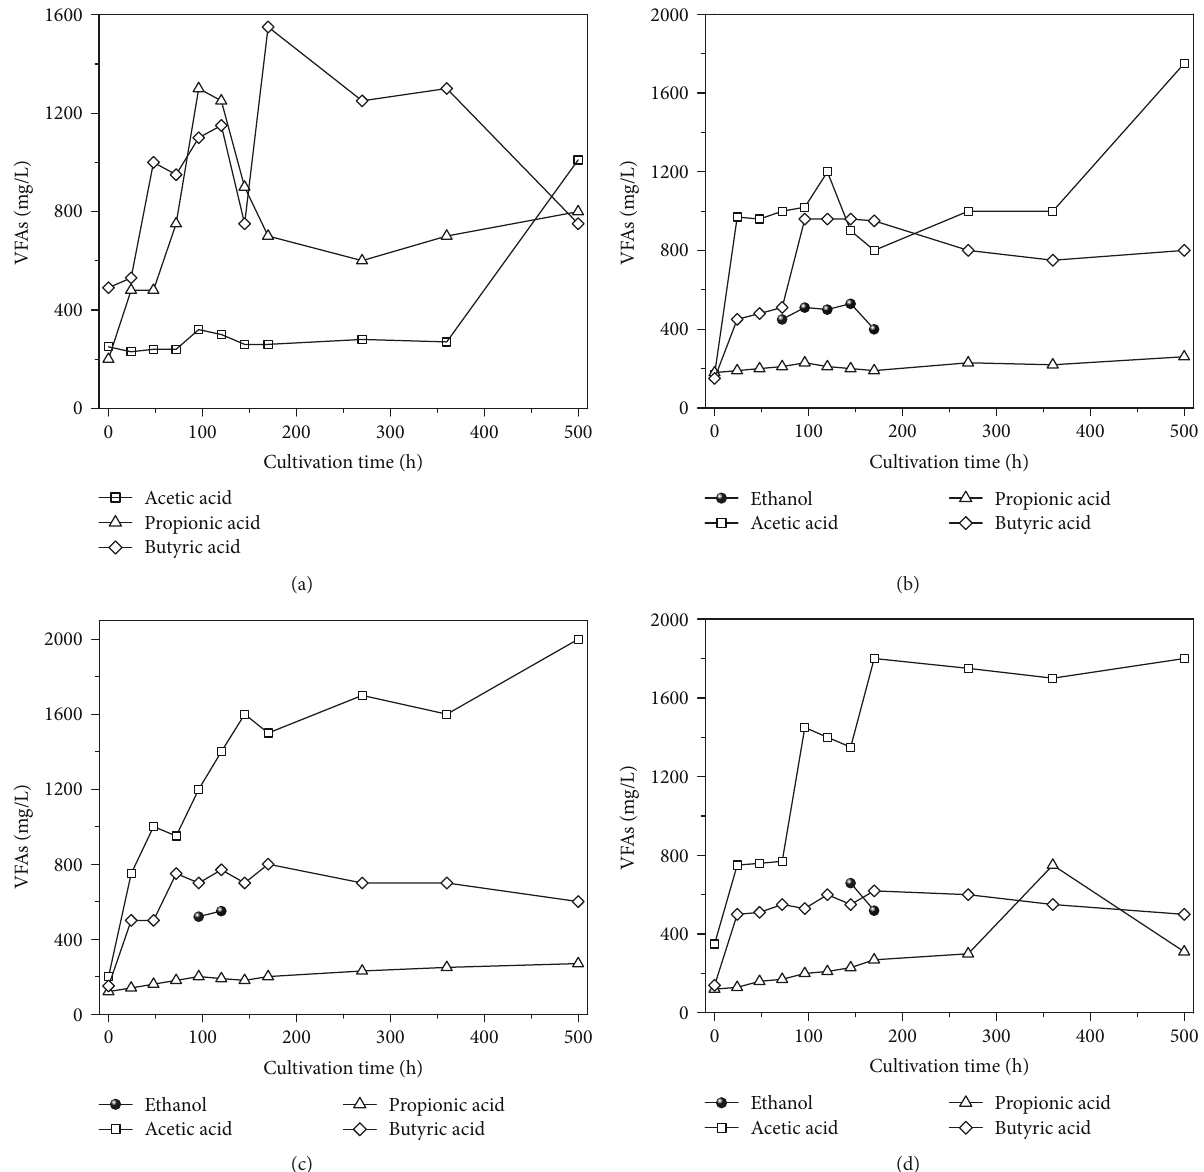
Figure 5: Terminal soluble products through normal molasses conversion of QJ1 (a), QJ2 (b), QJ3 (c), and QJ4